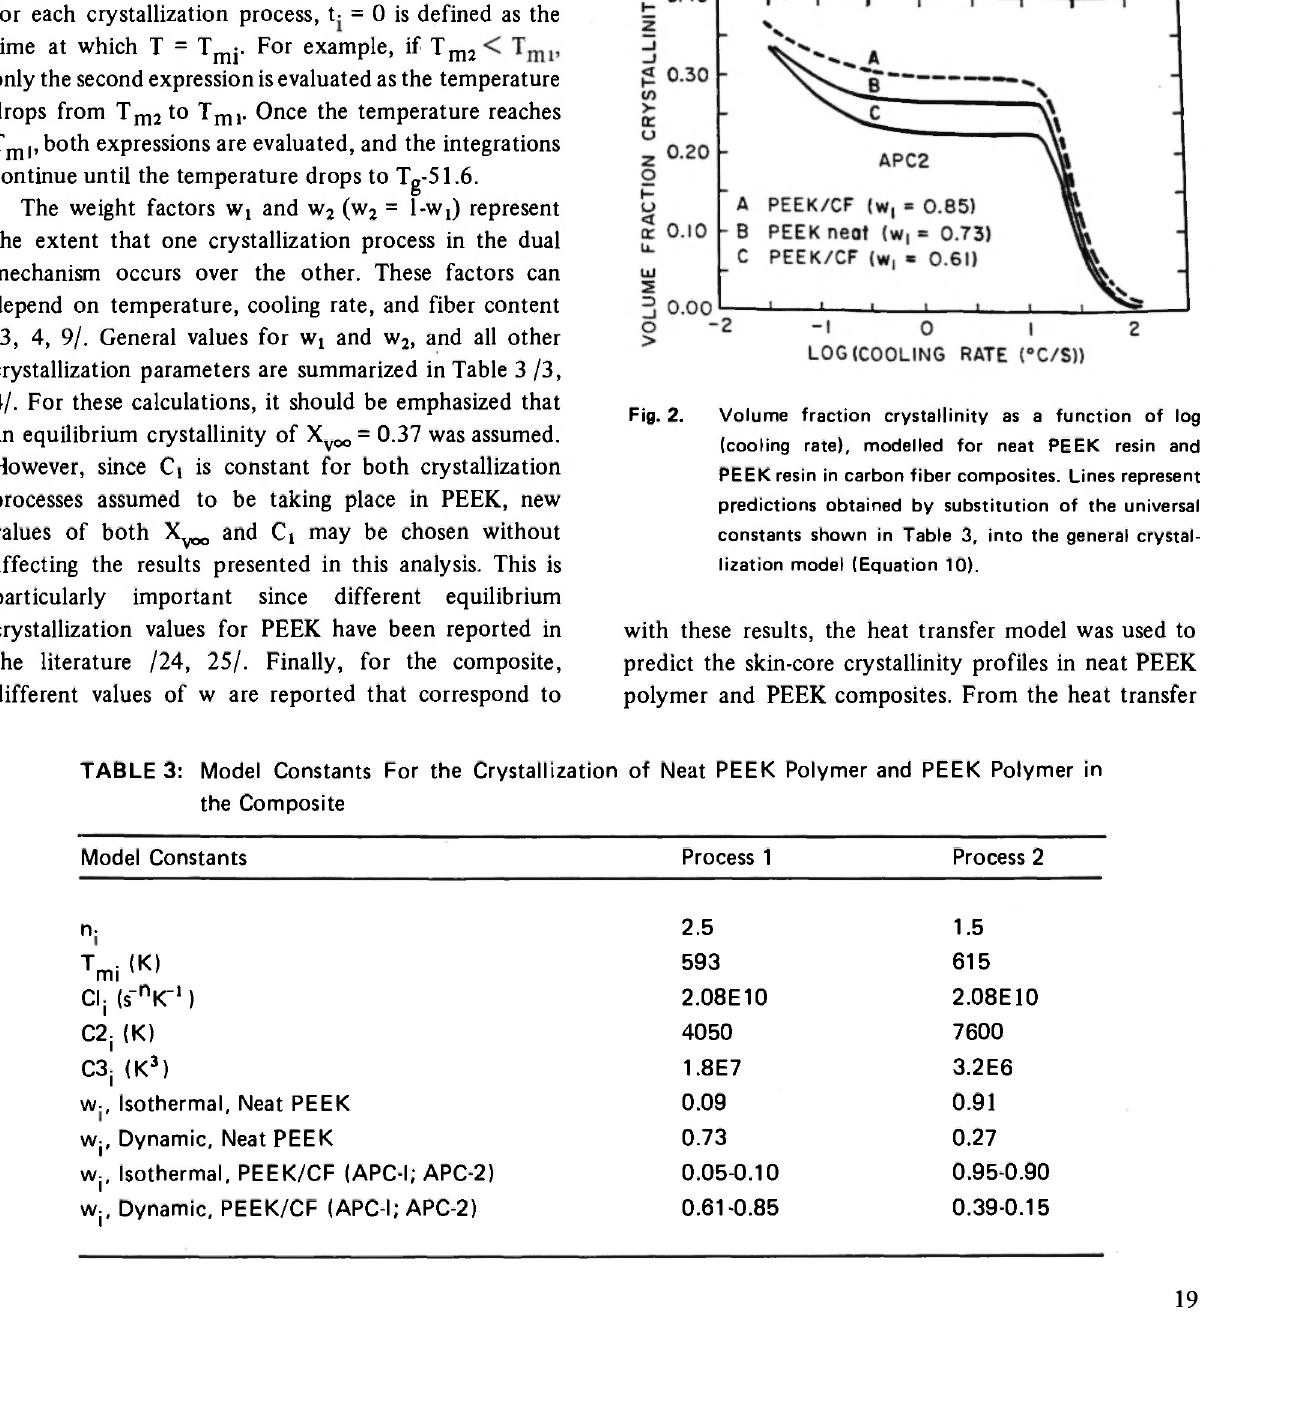
Fig. 2. Volume fraction crystallinity as a function of log (cooling rate), modelled for neat PEEK resin and PEEK resin in carbon fiber composites. Lines represent predictions obtained by substitution of the universal constants shown in Table 3, into the general crystal- lization model (Equation 10).